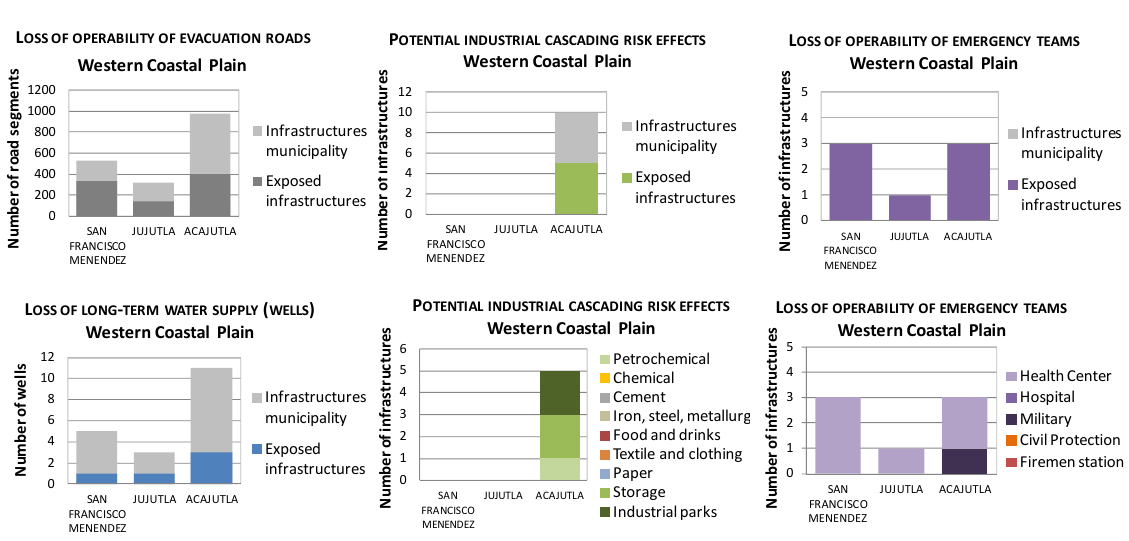
Figure 7. Expected impacts in the Western Coastal Plain of El Salvador: (a) impacts on socioeconomic activities, and (b) impacts on